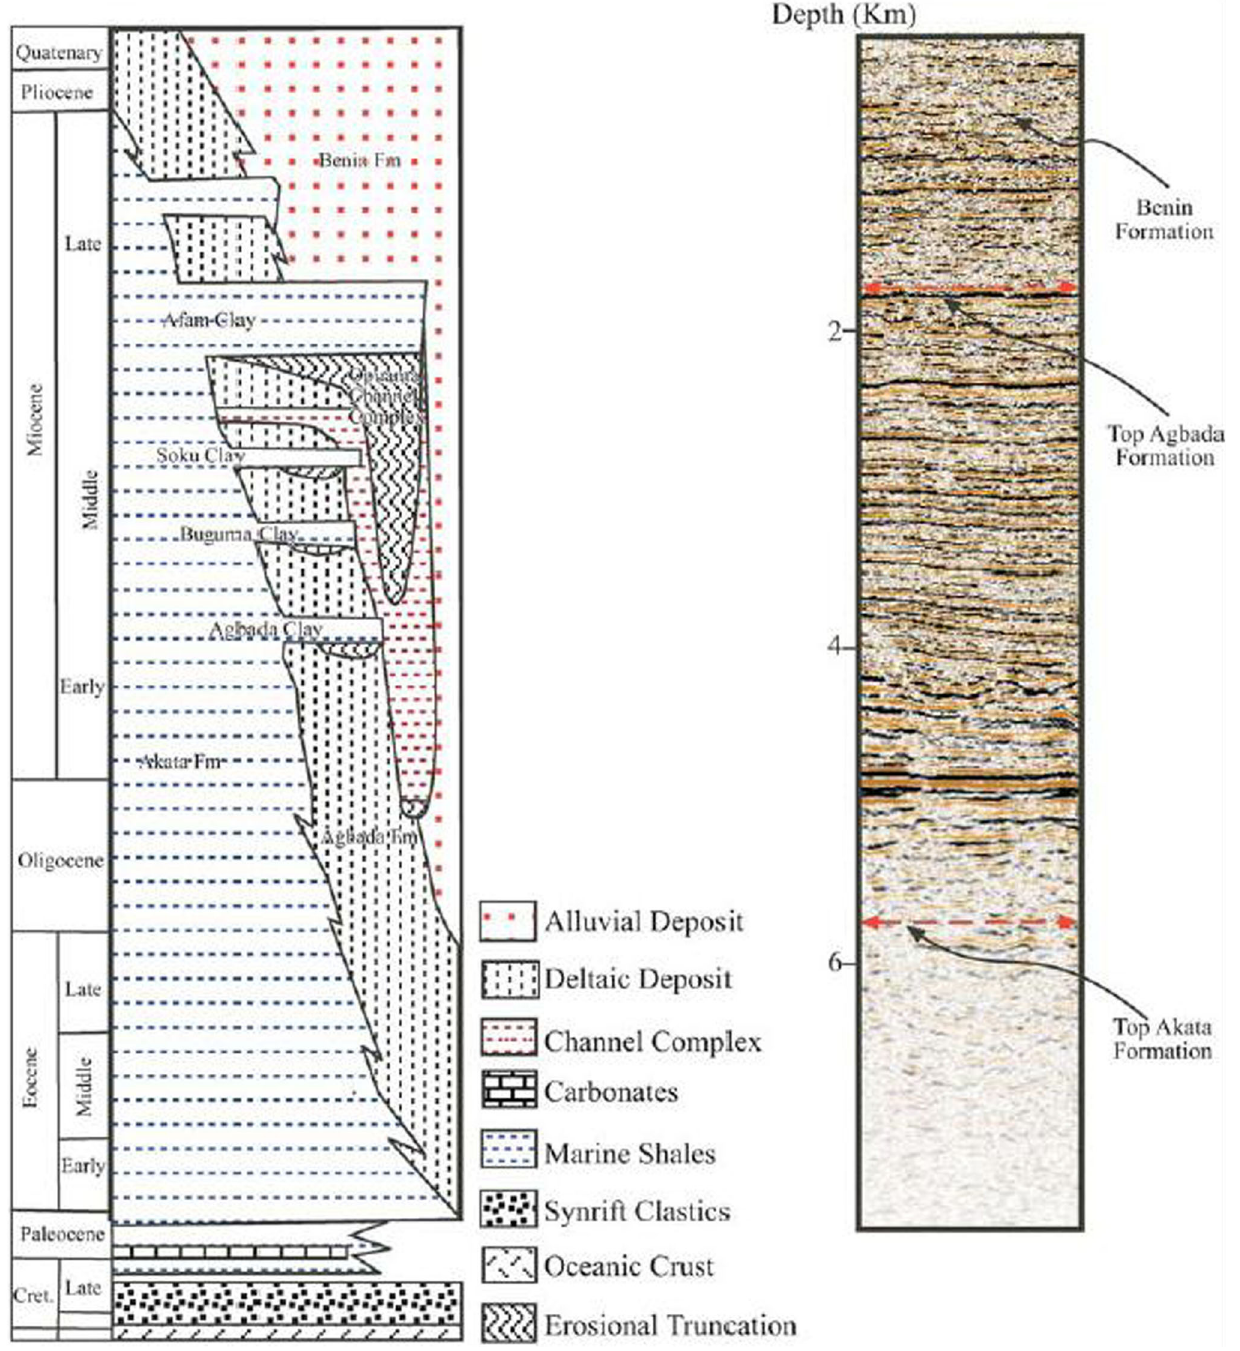
Fig. 2 Niger Delta regional stratigraphy and variable density seismic display of the main stratigraphic units with corresponding reflections (Lawrence et al.